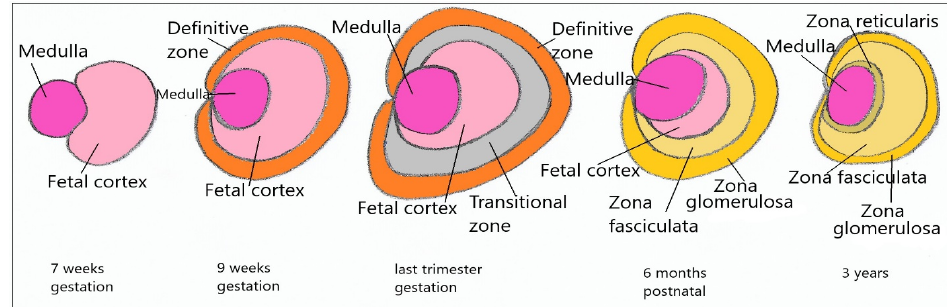
Figure 6. Adrenal gland development.